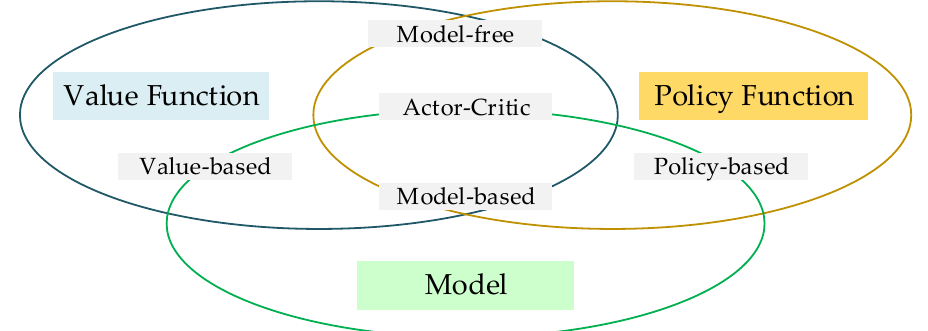
Figure 4. Overview taxonomies of DRL.